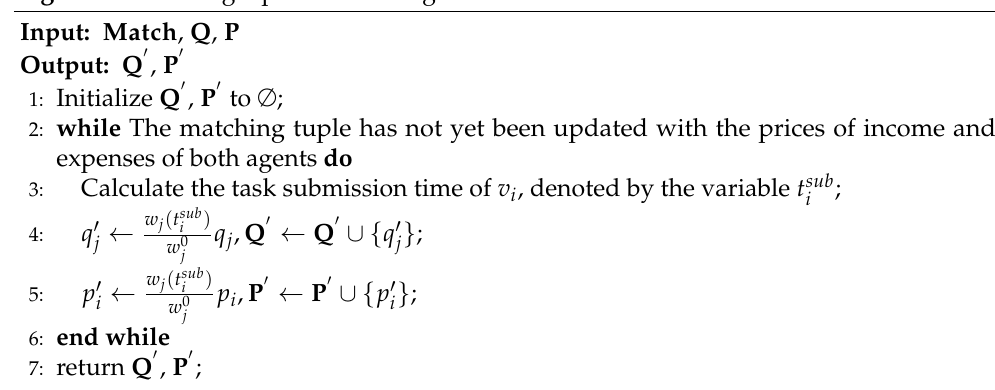
Algorithm 4 Pricing Optimization